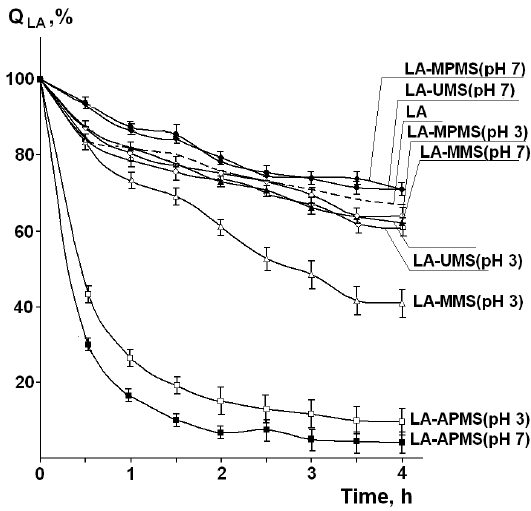
Figure 6. Experimental kinetic curves of photodegradation of free LA and LA in the composites (Q LA is the amount of LA remaining unchanged after the irradiation). (Mean value ± SD, n = 3). Table 4. Kinetic parameters of photodegradation of free LA and LA in the synthesized composites. Composite Zero-Order Model First-Order Model Second-Order Model